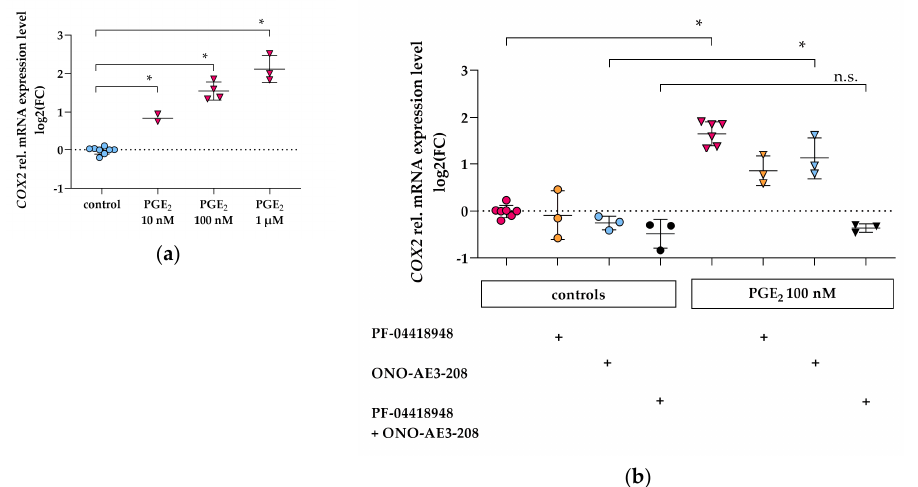
Figure3. COX2 geneexpressionisincreasedbyPGE 2 Figure 3. COX2 gene expression is increased by PGE 2 via EP2 and EP4 in hPC. qPCR results are